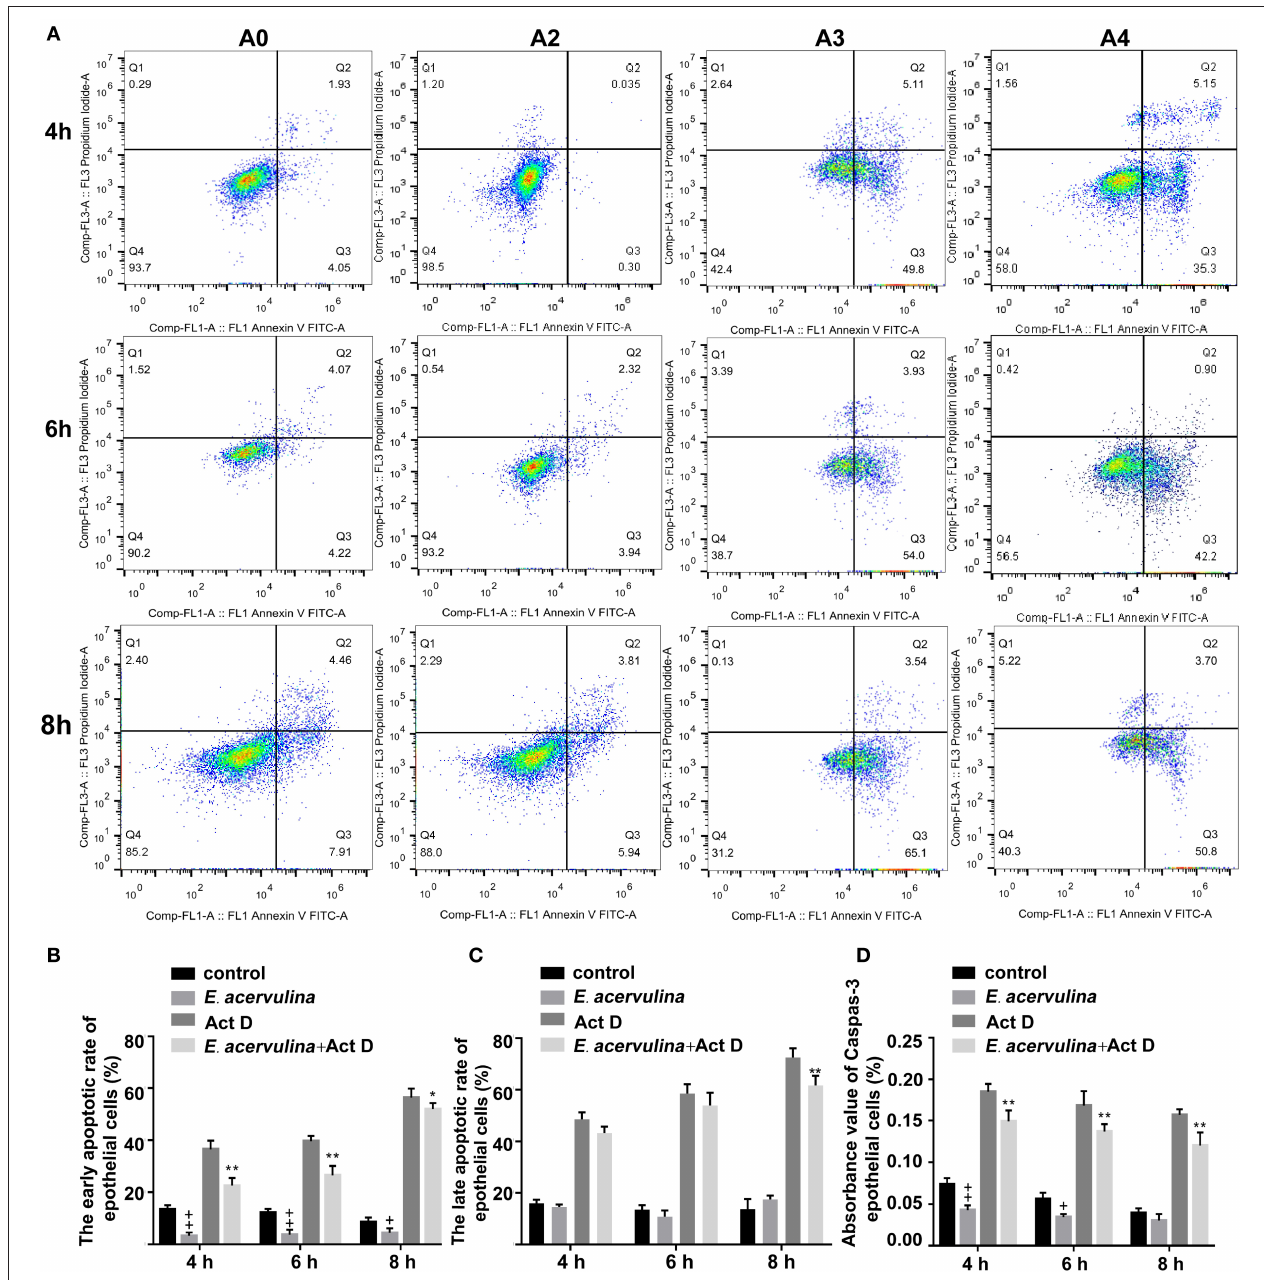
FIGURE 1 | Effects of early and late apoptosis on epithelial host cells after E. acervulina infection. (A) The apoptosis/necrosis rate of chick duodenal epithelial cells was detected by Annexin V/PI assay after E. acervulina merozoite infection. (B) Quantitative determination of the early apoptosis rate ( n = 3). + P < 0.01 vs. the control. (C) Quantitative determination of the late apoptosis/necrosis rate ( n = 3). + P < 0.01 vs. the control. (D) Analysis of caspase-3 activity after E. acervulina merozoite infection. + P < 0.01 vs. the control. “ + ” represents the apoptotic rate of host cells in E. acervulina merozoite group was significantly lower than that in the blank control group ( + P < 0.05). “ + ” represents the apoptotic rate of host cells in E. acervulina merozoite group was significantly lower than that in the blank control + group ( + P < 0.01). “ * ” represents the early apoptotic rate of host cells in E. acervulina merozoite + Act D group was significantly lower than that in the Act D group ( + P < 0.05). “ ** ” represents the early apoptotic rate of host cells in E. acervulina merozoite + Act D group was significantly lower than that in the Act D group ( + P T -test were used to statistically analyze the data. A0 represents the blank control group. A2 represents E. acervulina infection group. A3 represents Act D infection group. A4 represents E. acervulina + Act D infection